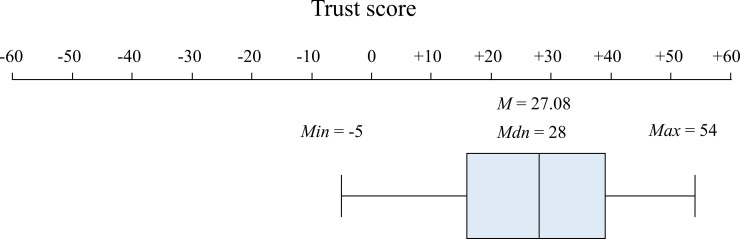
Distribution of the trust score in a box-plot.N = 65. Possible range of the trust score: -54 to +54. Note that the trust score exhibits considerable variation and its mean score is clearly positive. See S2 Fig for detailed information on investments, which we used to calculate the trust score.